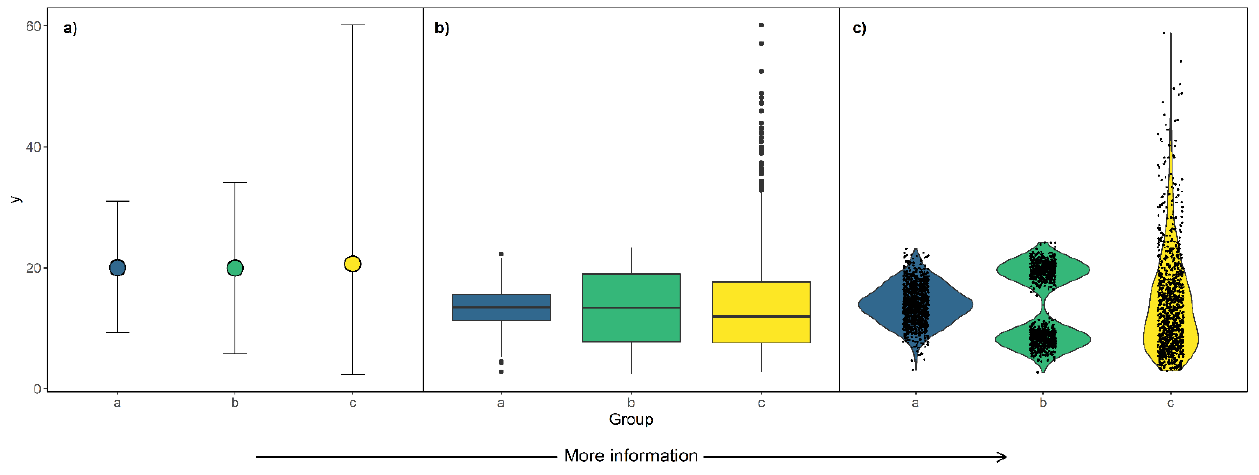
Figure 1. Example figure types to represent the posterior probability distribution. Groups in each pane use the same Monte Carlo samples. A displays the median (colored points) and bounds of the 95% Bayesian posterior probability intervals. B displays boxplots of the 25%, 50%, 75% quartiles, upper and lower bars represent the bounds of the 95% Bayesian posterior probability intervals, and points are the Monte Carlo samples that fall outside of the 95% Bayesian posterior probability intervals. C displays all Monte Carlo samples (points) that have been jittered to emphasize cluster, and violin